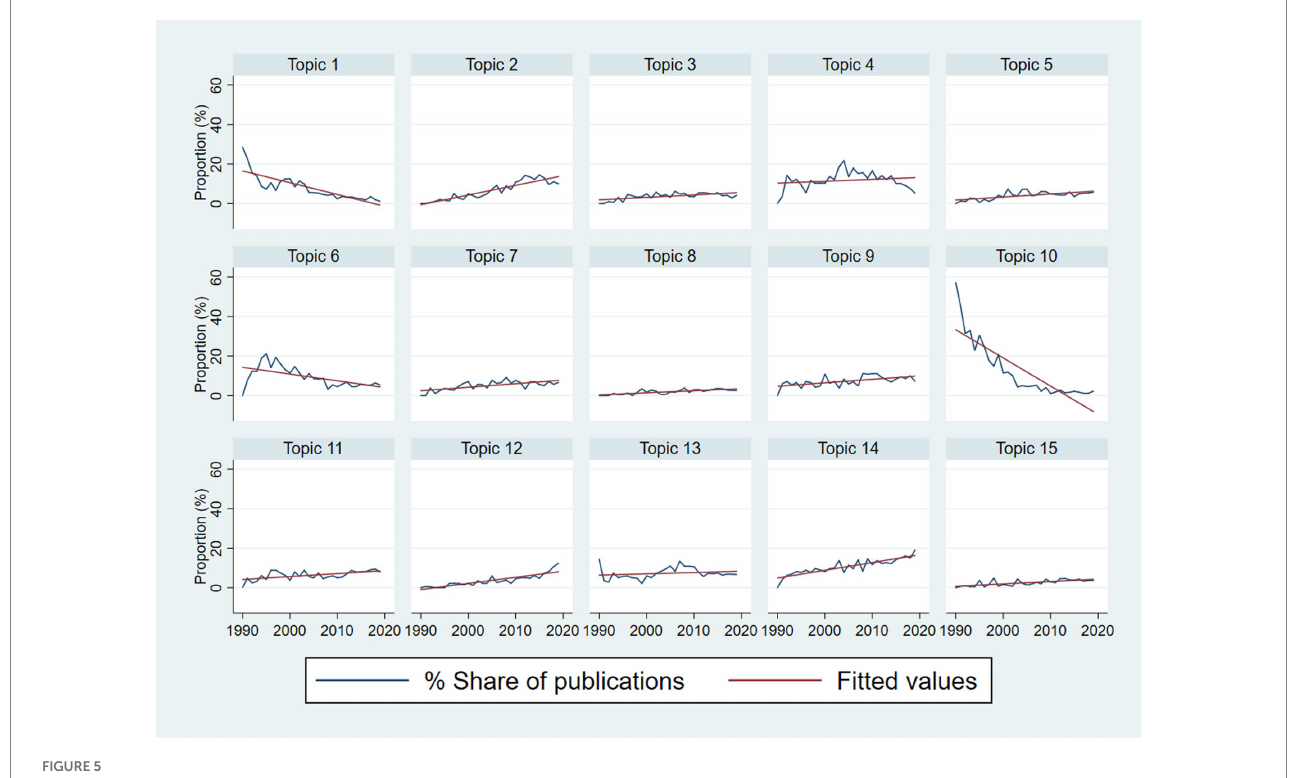
FIGURE 5 Trends in research topics by year during 1990–2019.